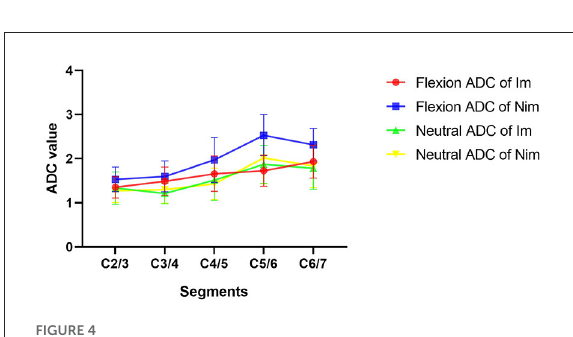
A comparison of preoperative EMG data between the two groups of patients is shown in Table 3. We compared four indices, including the CMAP amplitude of the ulnar nerve, the CMAP amplitude of the median nerve, fibrillation and positive sharp waves of FDI and fibrillation and positive sharp waves of ABD. We found that only the CMAP amplitude of the ulnar nerve differed significantly between the two groups (Im group vs. Nim group: 5.92 ± 4.59 vs. 3.29 ± 2.34, P = 0.041).